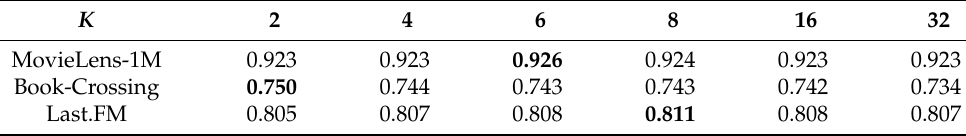
Table 6. Results of AUC on three datasets with different item neighbor sampling sizes.